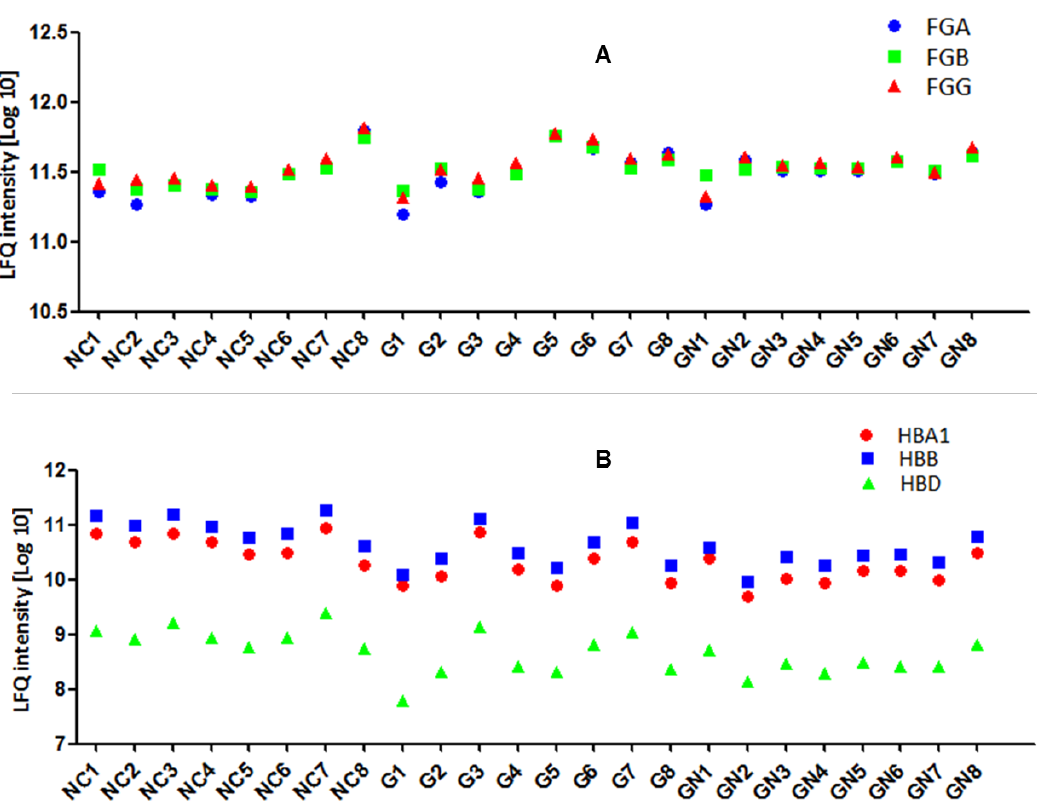
Figure 3. Among the 24 plasma samples, we measured the evaluation of plasma coagulation and hemolysis events. ( A ) Analysis of protein abundance of FGA, FGB, and FGG in 24 plasma samples. ( B ) Analysis of protein abundance of HBA1, HBB, and HBD in 24 plasma samples.